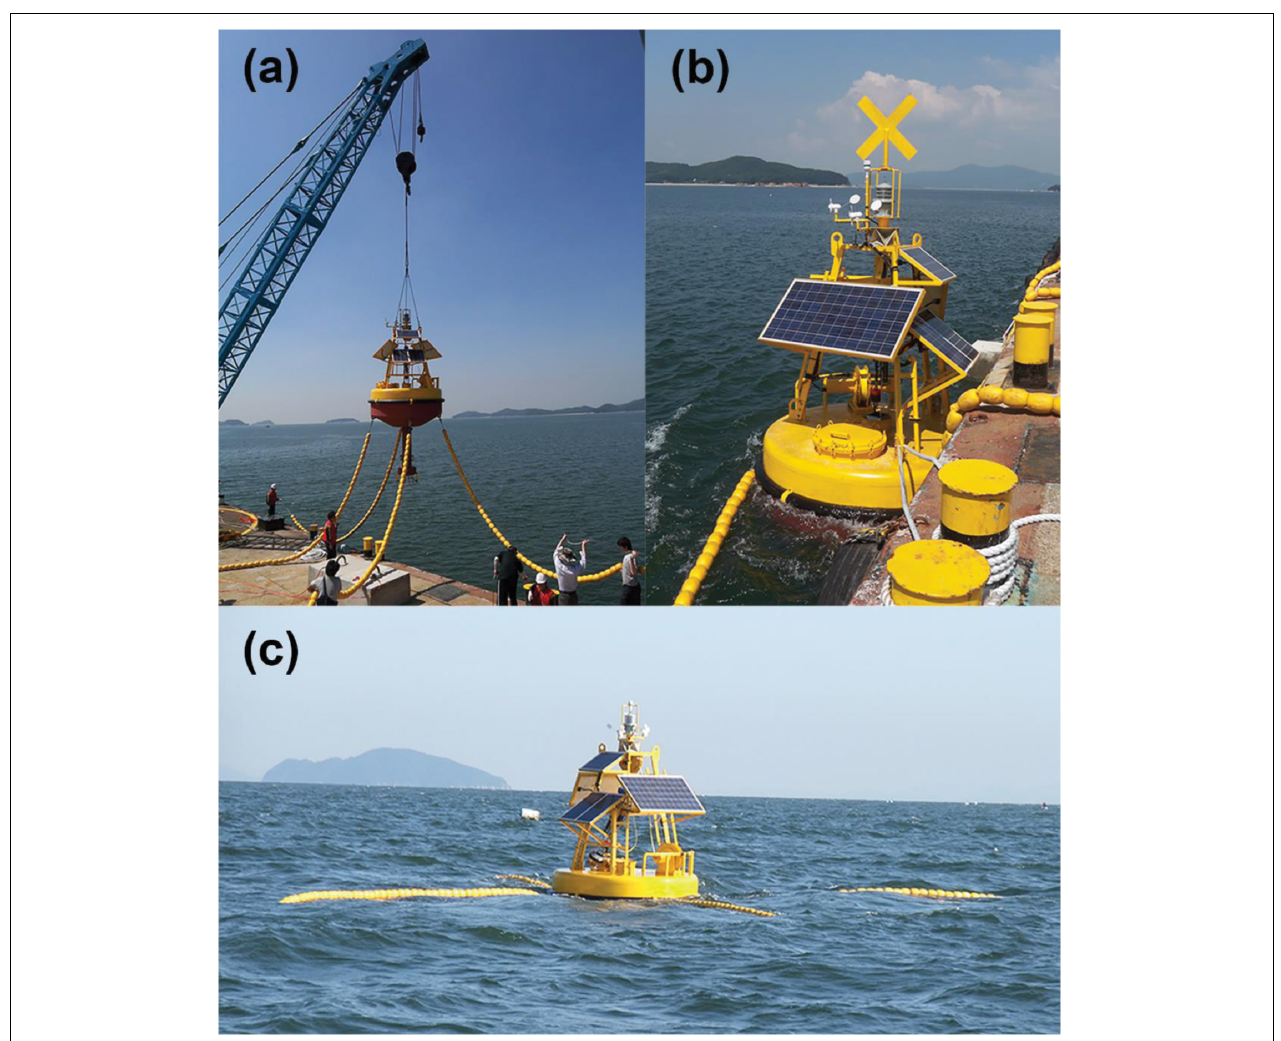
FIGURE 2 | (a,b) Photographs of INBUS-2 before mooring and (c) after